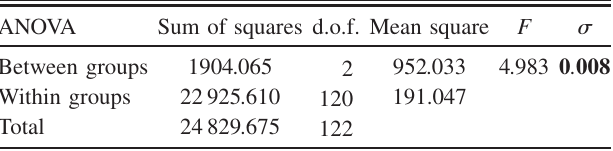
TABLE I. ANOVA of the variable ‘‘learning.’’ ANOVA Sum of squares d.o.f. Mean square F (cid:1) Between